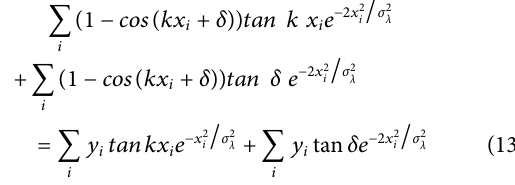
Frontiers in Chemistry |